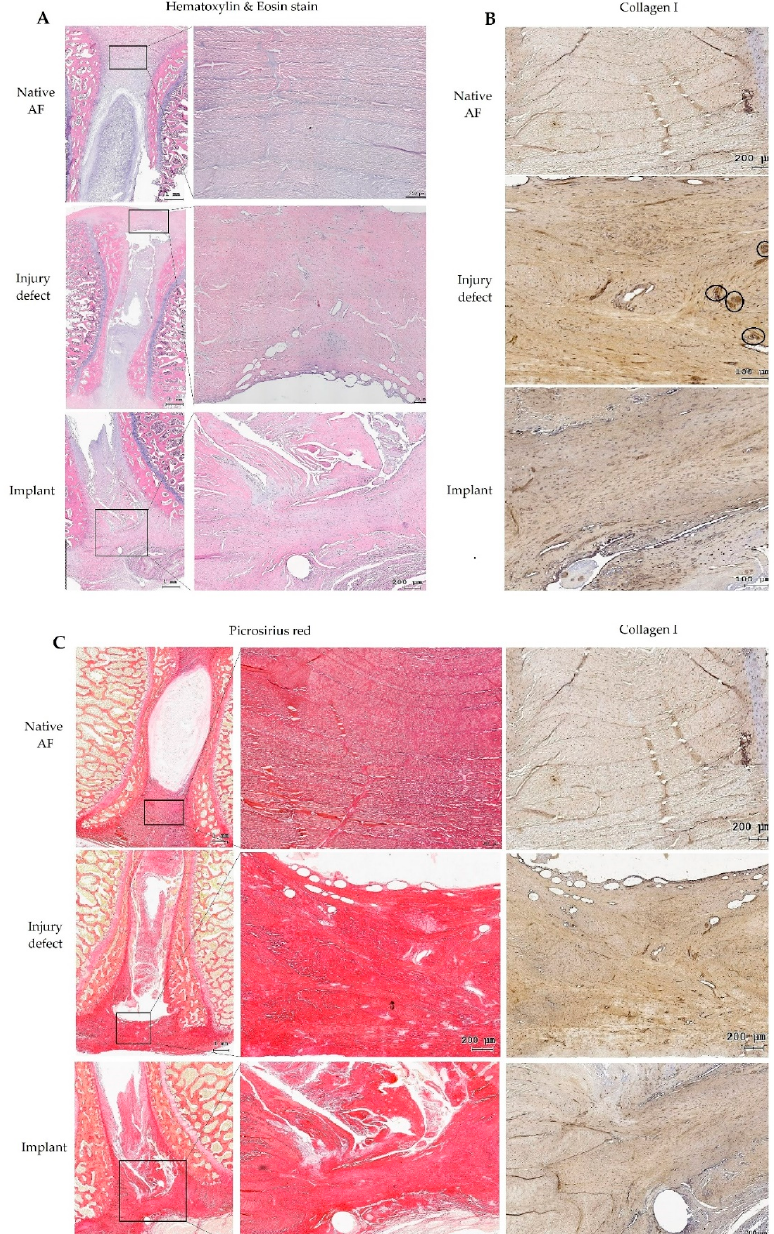
Figure 11. In vivo study with explanted intervertebral disc at 12 weeks after the surgery. ( A ) H&E staining in control group demonstrated a native AF with regular and intact inner AF lamellae. In injury group, empty defect without implant showed irregular fibrous reparative tissue with highly cellularized with fibroblast-like cells. In the implant-repaired AF, the multilayer fibroin/gelatin scaffolds were well healed within the outer AF defects without any sign of dislodgement. ( B , C ) Picrosirius red staining and type I collagen immunohistochemical staining revealed positively stained fibrous tissue in an aligned pattern within the implant-integrated site. In the injury defect group, this collagen-rich tissue was disorganized with no preferential orientation of the neosynthesized collagen fibers with numerous vascular ingrowths. (black circles, panel